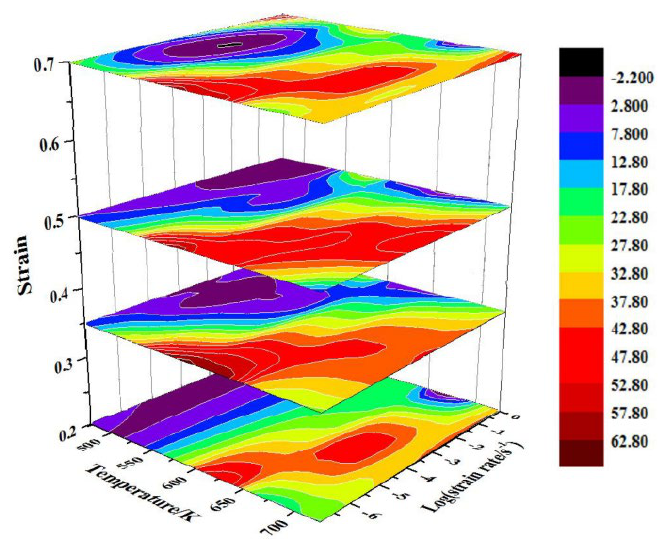
Figure 6. The 3D maps of power dissipation efficiency of the Mg − 2Sn − 1Ca alloy at various strains.